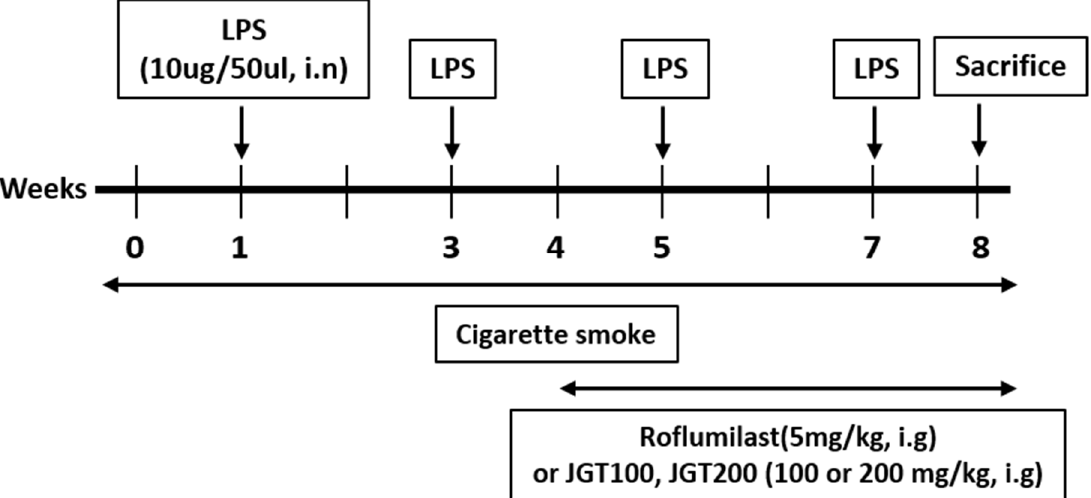
Figure 1. Experimental procedure for the introduction of COPD in mice and treatment with JGT.